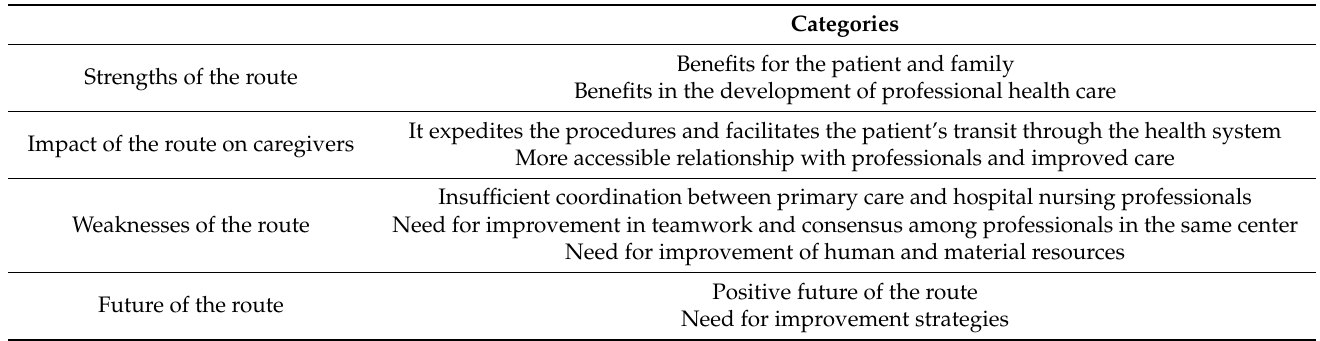
Table 3. Distribution of the main categories and